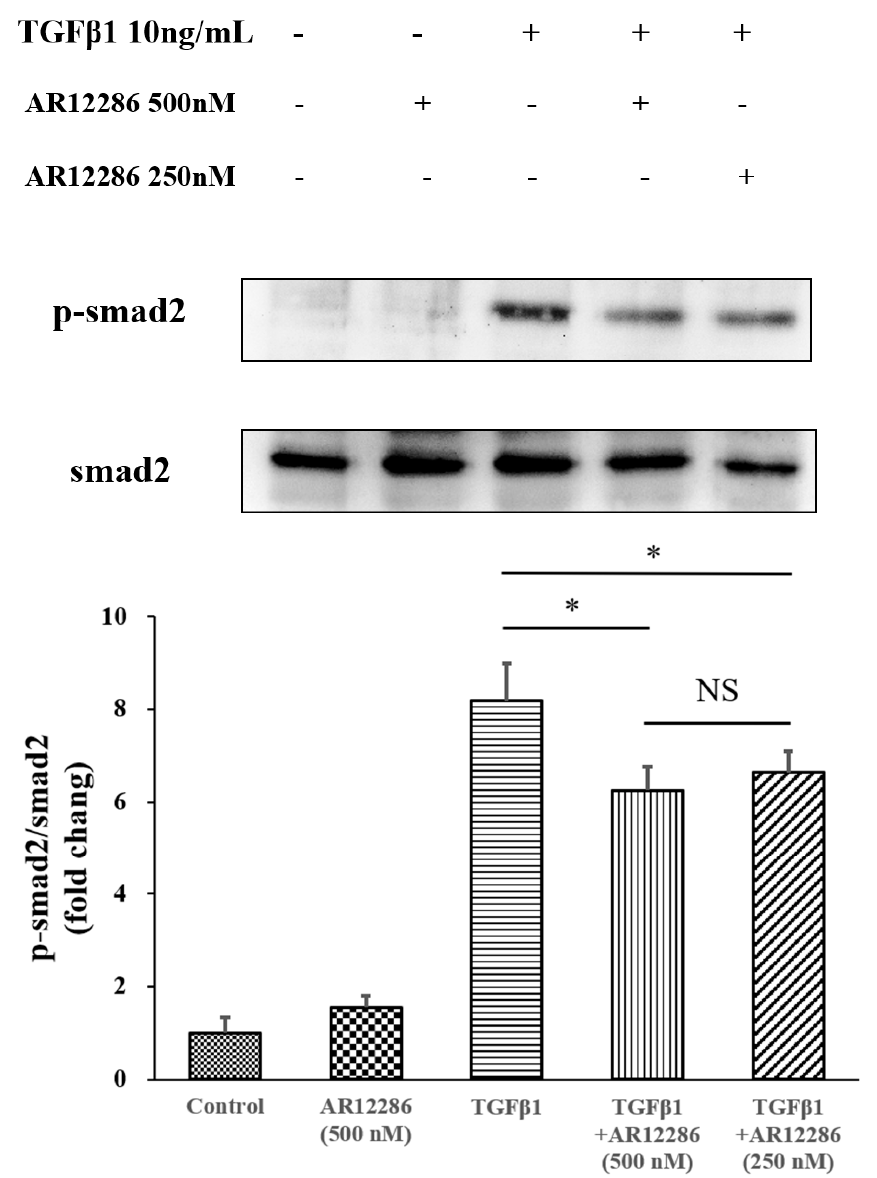
Figure 8. E ff ect of AR12286 on SMAD deactivation. SMAD2 expression and phosphorylation are illustrated. Serum-starved HConFs pretreated with either 250 or 500 nM AR12286 for 24 h. Cells were treated with TGF- β 1 for 60 min, and cell lysates were immunoblotted with antiphosphorylated and antitotal antibodies. Protein loading normalized with GAPDH antibodies. Compared with ratios of the control group, those of p -SMAD2 to total SMAD2 increased after TGF- β 1 stimulation, and decreased after treatment with 250 or 500 nM AR12286. Ratio presented as means ± SEM ( n = 6). Asterisks indicate significantly di ff erent responses: *, p < 0.05. NS signifies no significant di ff